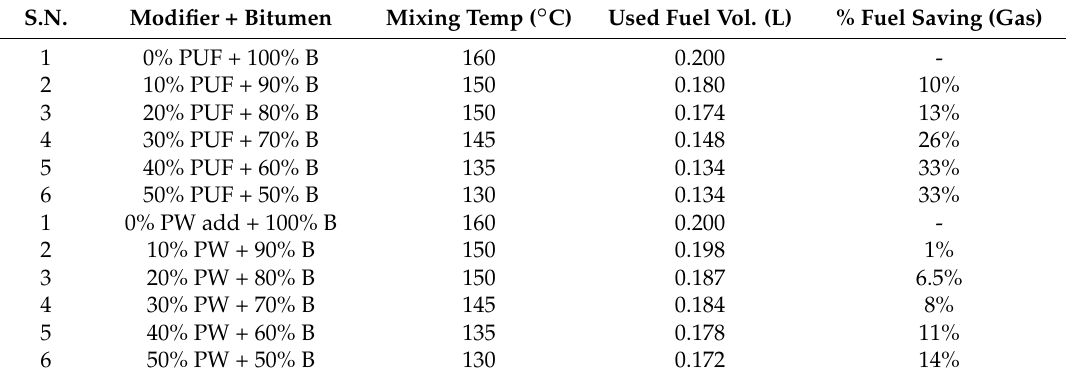
Table 6. Fuel saving analysis of asphalt mix production with modified and unmodified bitumen. S.N.